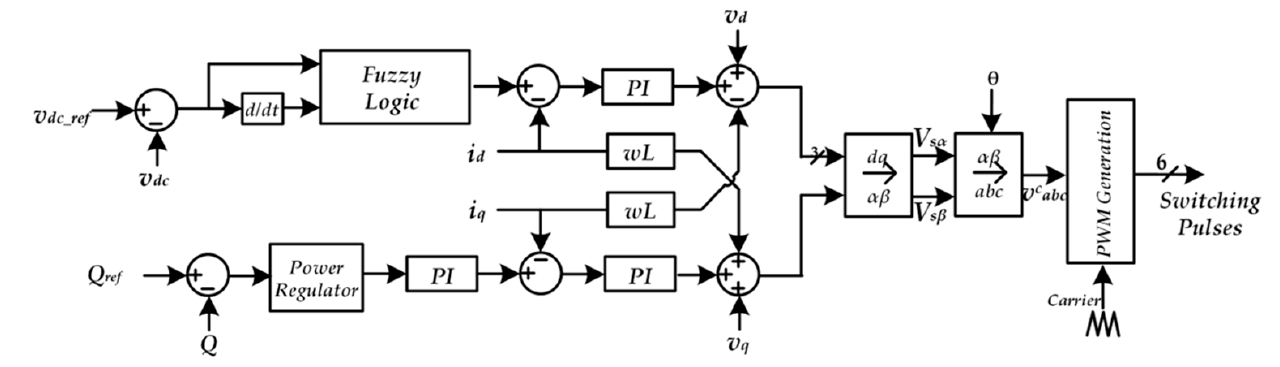
Figure 27. Fuzzy-PI based Control Strategy for EV battery Charging/Discharging.